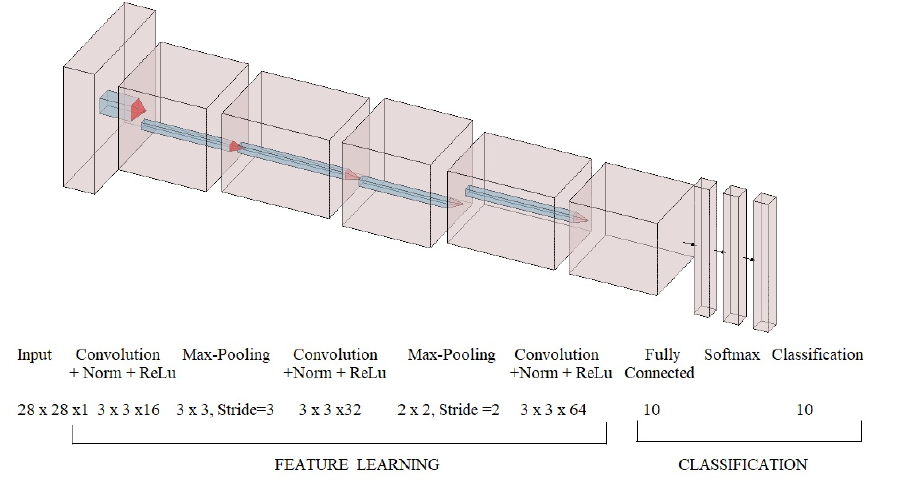
Figure 8. The architecture of the CNN used for Digits